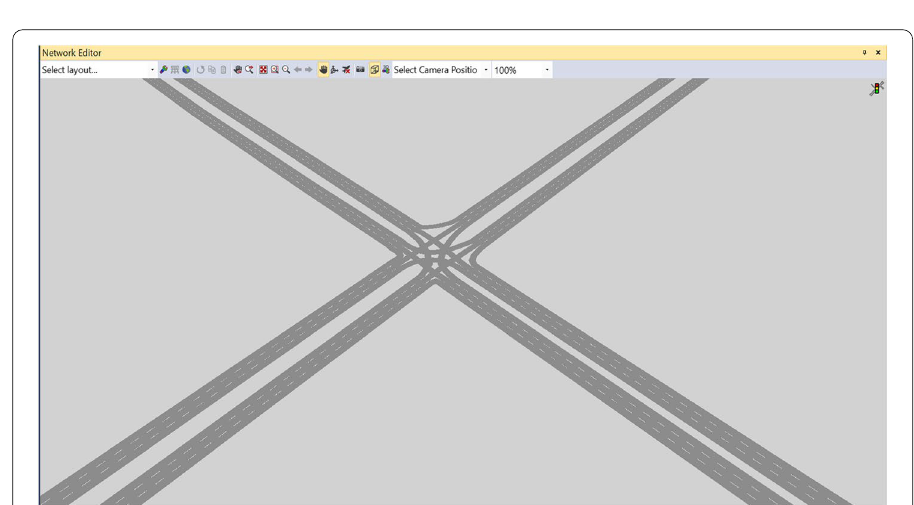
Fig. 5 VISSIM simulation model of conventional Al Sakhara intersection